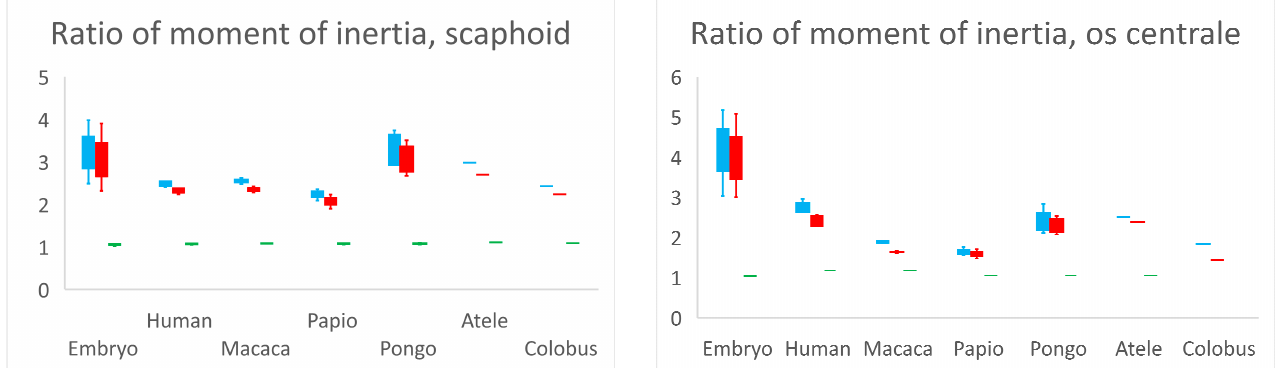
Figure 4. Ratios of moment of inertia I xx /I zz (blue), I yy /I zz (red) and I xx /I yy (green). Ratio I xx /I yy is close to 1.0 for all specimens and for scaphoid and os centrale signifies that the moment of inertia and distribution of mass is almost the same around x -axis and y -axis in each specimen. The higher distribution of mass around the x -axis or y -axis compared to the z -axis (ratios I xx /I zz and I yy /I zz >2) represents the elongated tubular shape, which characterizes the scaphoid bones of all our specimens and most of the centrale bones.